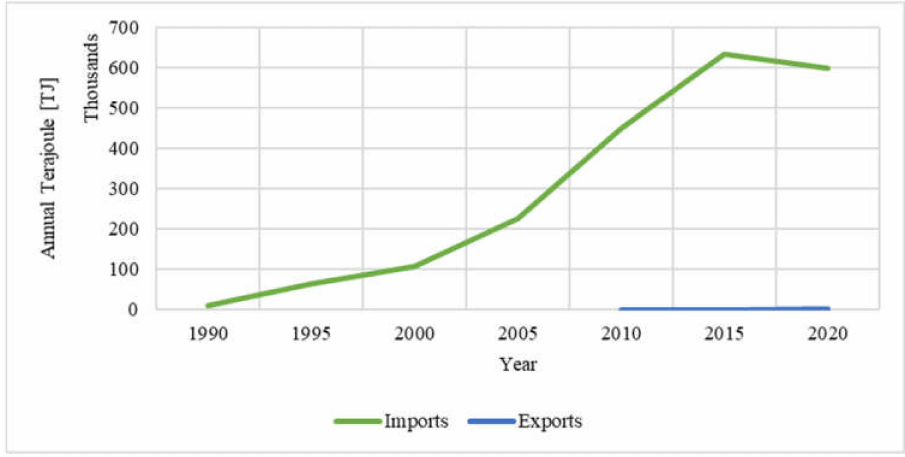
Figure A2. Historic coal imports and exports of Thailand based on data by